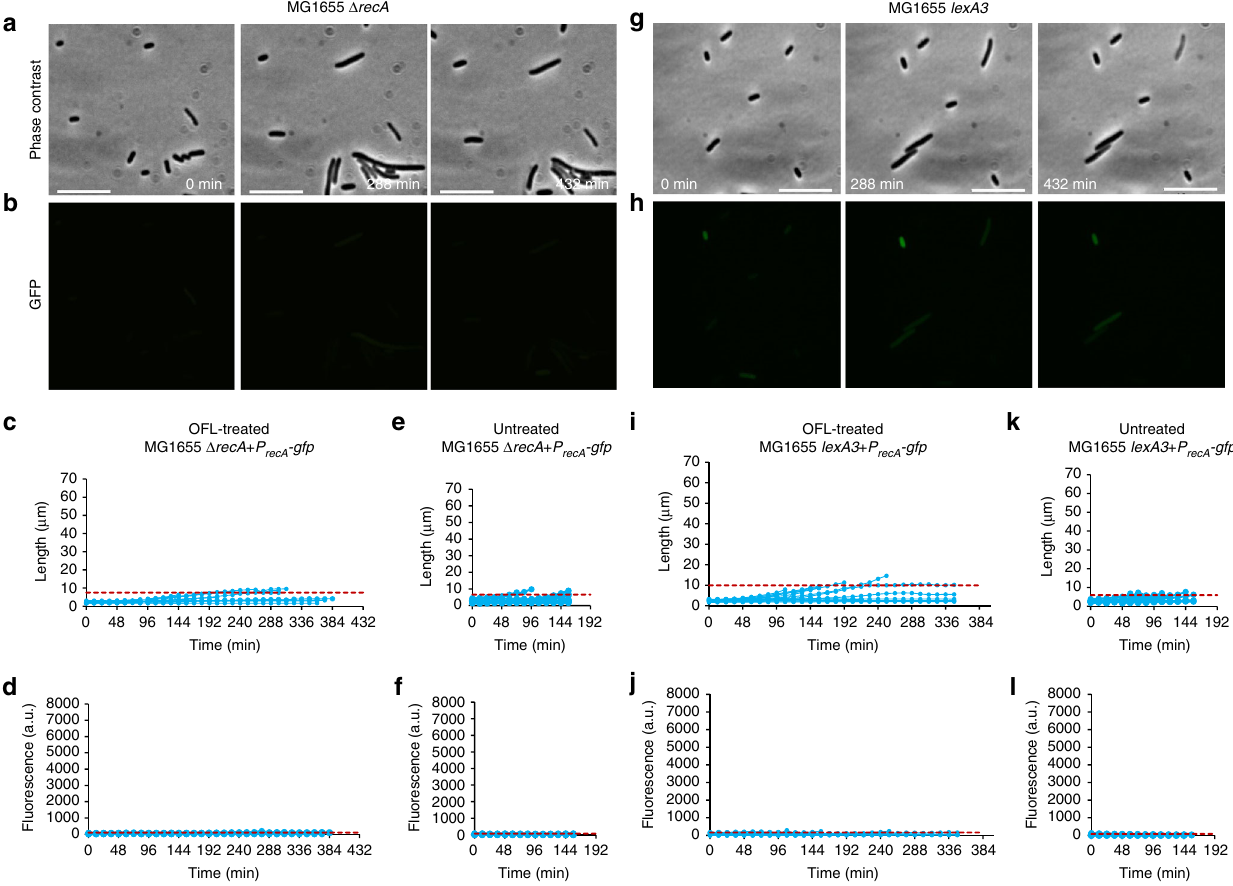
Fig. 2 Time-lapse microscopy of E. coli MG1655 Δ recA and MG1655 lexA3 . a Representative phase contrast and b GFP fl uorescence images of recovering OFL-treated MG1655 Δ recA harboring P recA -gfp . Growth and fl uorescence of OFL-treated ( c , d ) and untreated ( e , f ) MG1655 Δ recA recovering from treatment were analyzed. g Phase contrast and h GFP fl uorescence images of OFL-treated MG1655 lexA3 harboring P recA -gfp . Growth and fl uorescence of OFL-treated ( i , j ) and untreated ( k , l ) MG1655 lexA3 recovering from treatment were analyzed. 95% of the cell length and fl uorescence measurements lie below the respective red dashed lines. Appreciable fi lamentation and fl uorescence enhancement, and persister formation were not observed in either mutant. Fifteen cells from each treatment condition were quanti fi ed. The scale bars represent 10 μ m. Refer to Supplementary Movies 5 – 8 for